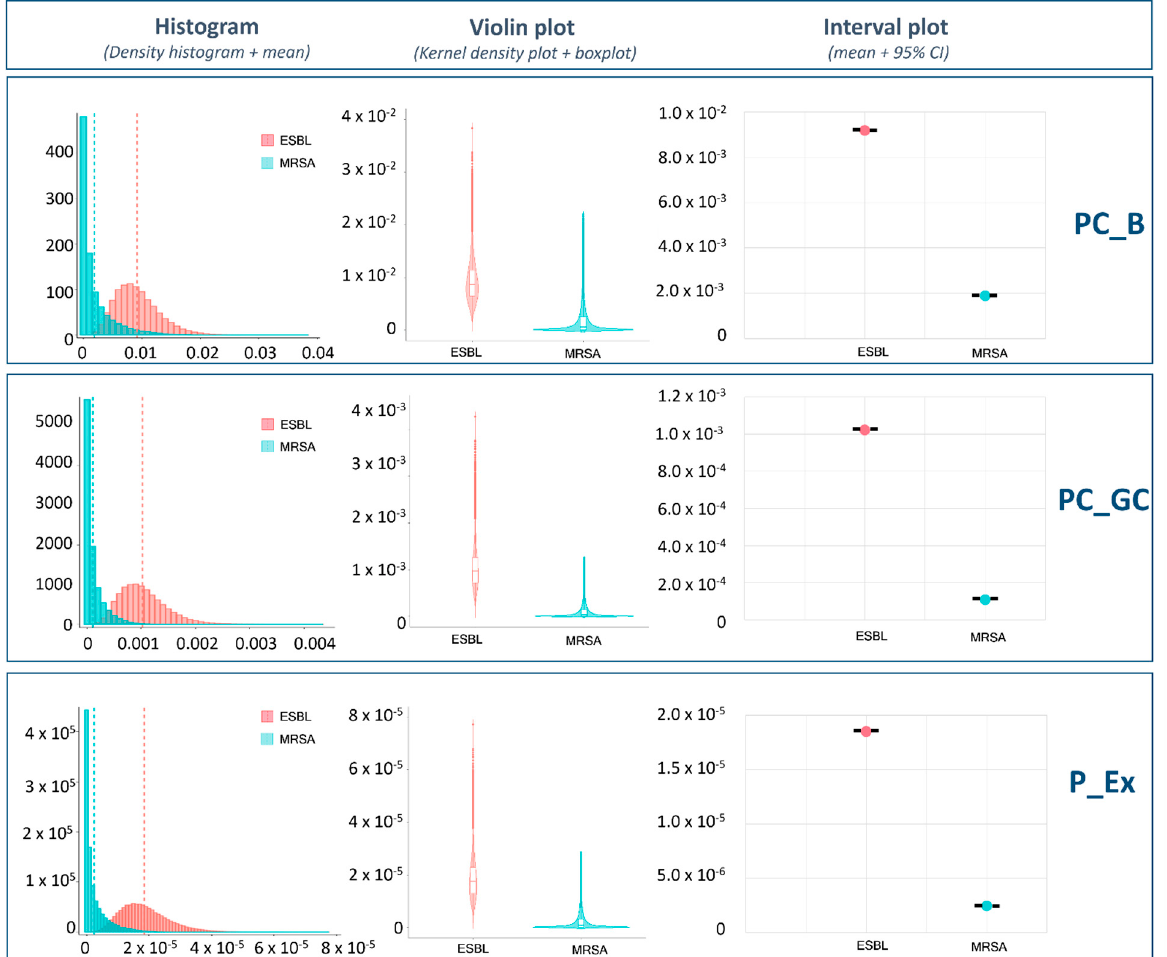
Figure 6. Comparative analysis of consumer exposure between ESBL-/AmpC-producing E. coli and MRSA, where the probability of one CFU to be transferred to bread (PC_B), grilled chicken (PC_GC) and the final serving (P_Ex) is graph- ically represented.